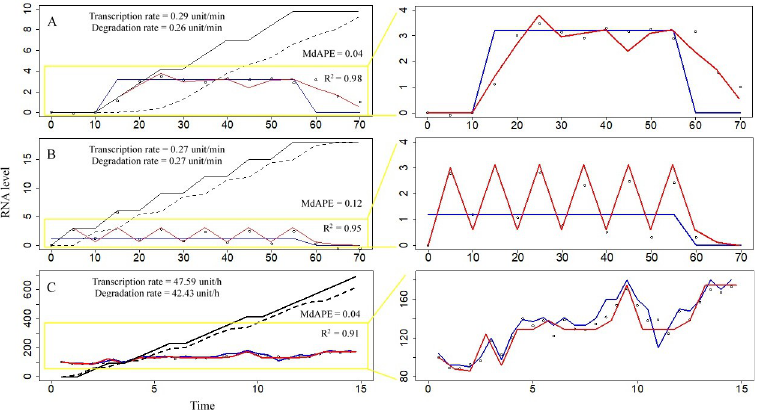
Fig 1. Analysis of experimental data of single-cell RNA abundance using the present model. Hollow circles represent RNA levels of experimental data from the references [21,37].Blue line represents the demand for RNA activity (DRA). Red curve represents the RNA level of the simulation result of the model. Black solid line represents the cumulative transcription RNA level calculated by the model. Black dashed line represents the accumulated degradation RNA level calculated by the model. (A) Partially regular fluctuations: analysis of mRNA level fluctuations of the Saccharomyces cerevisiae HSP26 gene by the model. The experimental data have been reported by Hao and O’Shea (2011) [21]. The x-axis is time, and the unit of time is minute. The y-axis is the RNA level, and the unit is normalized fold change of mRNA level with the baseline subtracted. (B) Regular fluctuations: analysis of mRNA level fluctuations of the S . cerevisiae YNR014W gene by the model. The experimental data have been reported by Hao and O’Shea (2011) [21]. The x-axis is time, and the unit of time is minute. The y-axis is the RNA level, and the unit is normalized fold change of mRNA level with the baseline subtracted. (C) Irregular fluctuations: analysis of mRNA level fluctuations of the mouse GT1-1 cell GnRH gene by the model. The experimental data have been reported by Nu ñ ez et al. (1998) [37]. The x-axis is time, and the unit of time is hour. The y-axis is the RNA level, and the unit of mRNA level is normalized photonic